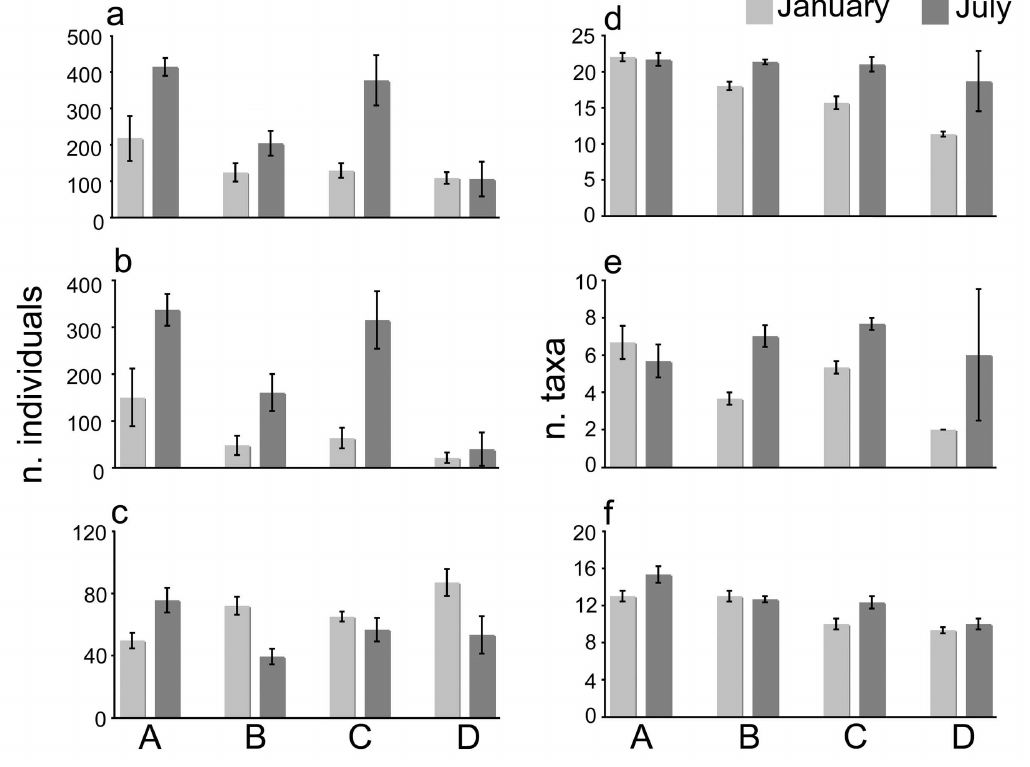
Fig . 2. – Abundance (as mean number of individuals per site ± S.E.) of the whole assemblage (a), the polychaetes (b) and the molluscs (c), and taxonomic richness (as mean number of taxa per site ± S.E.) of the whole assemblage (d), the polychaetes (e) and the molluscs